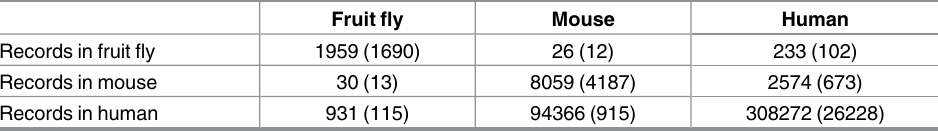
ues in brackets refer to training datasets in this